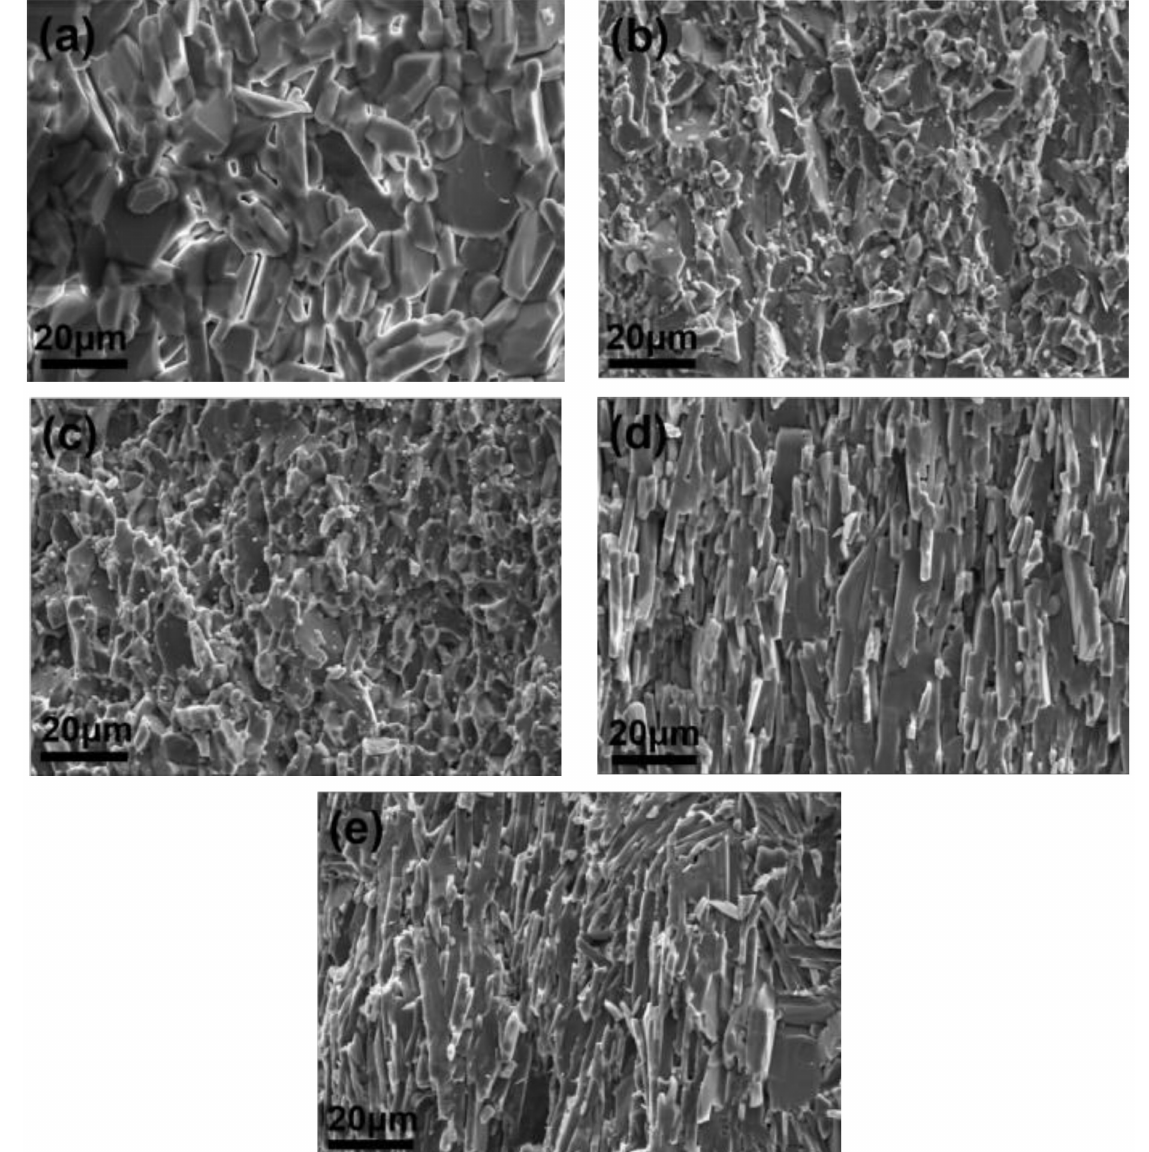
Figure 4. SEM images of fracture surface, ( a ) A1; ( b ) A2; ( c ) A3; ( d ) A4; ( e )